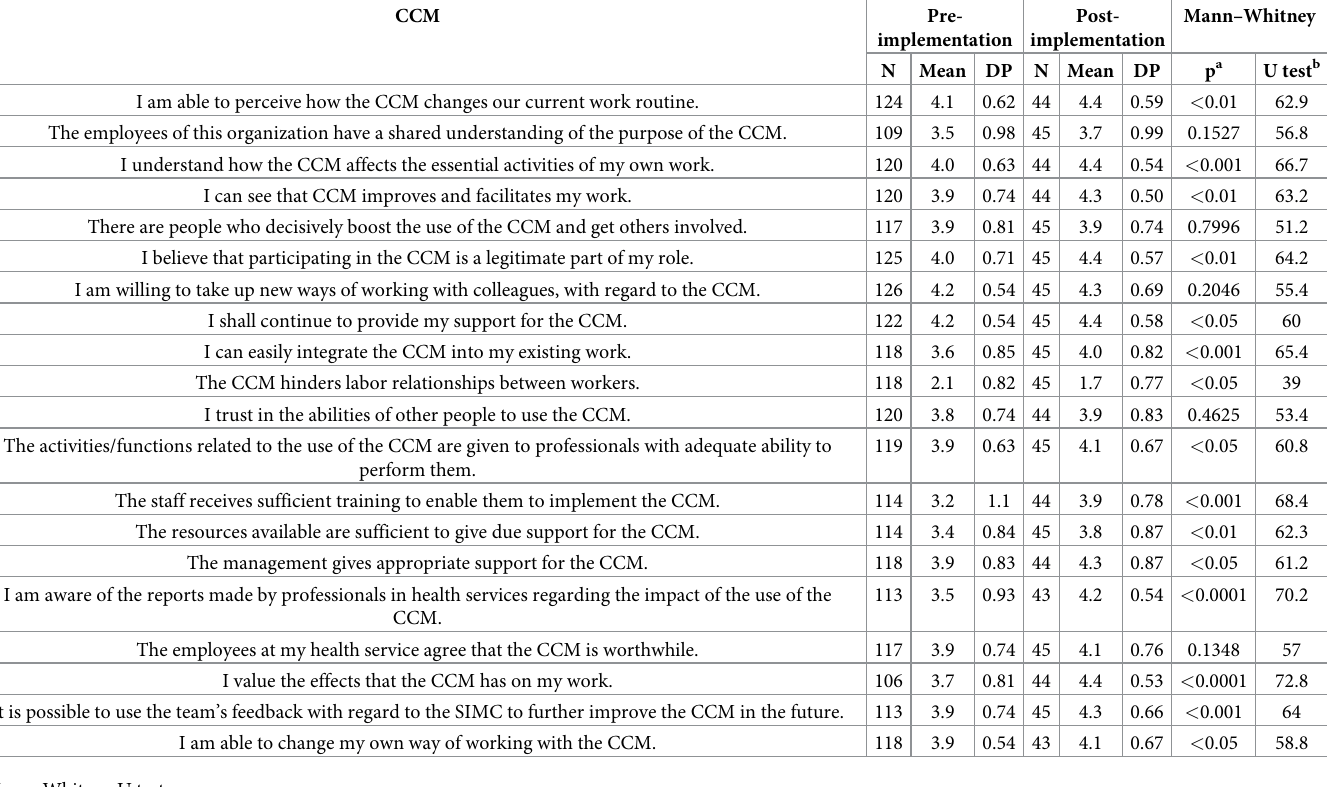
Table 7. Professional perceptions on the use of continuum of care (CCM) monitoring in pre- and post-implementation steps.